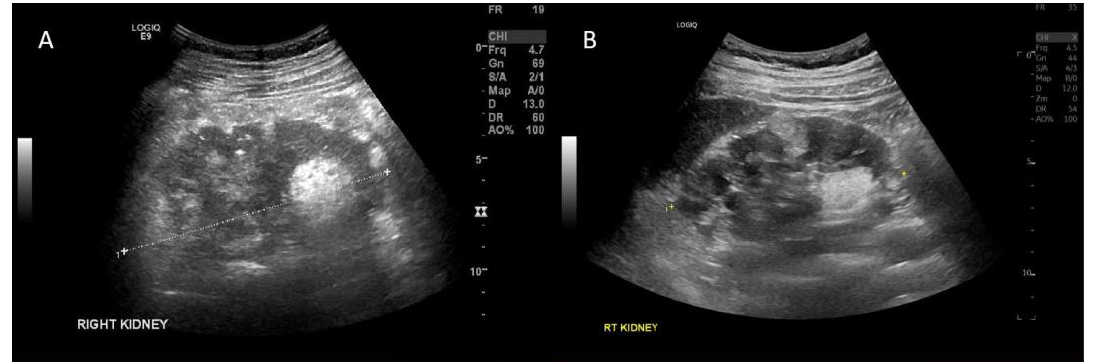
Figure 3. Kidney ultrasound demonstrating reduced size in right kidney lower pole angiomyolipoma before and after everolimus treatment. ( A ) — Pre-treatment [5.8 cm in diameter] ( B ) — Post-treatment [4.8 cm in diameter].